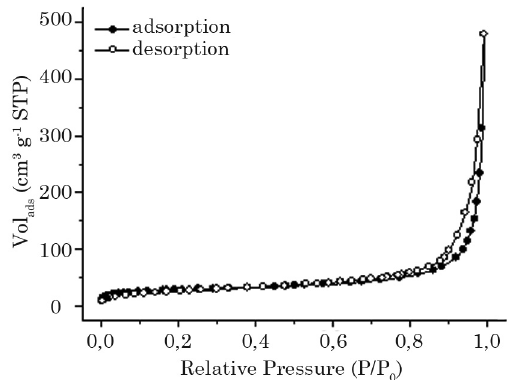
Figure 8. Nitrogen (N 2 ) adsorption-desorption isotherm of a ZnAl-CO 3 -LDH. Source: Tronto (non-published